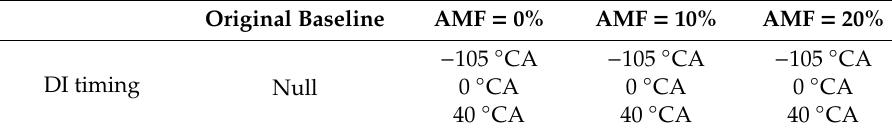
Table 3. Setting of the simulation cases and the legend nomenclature.